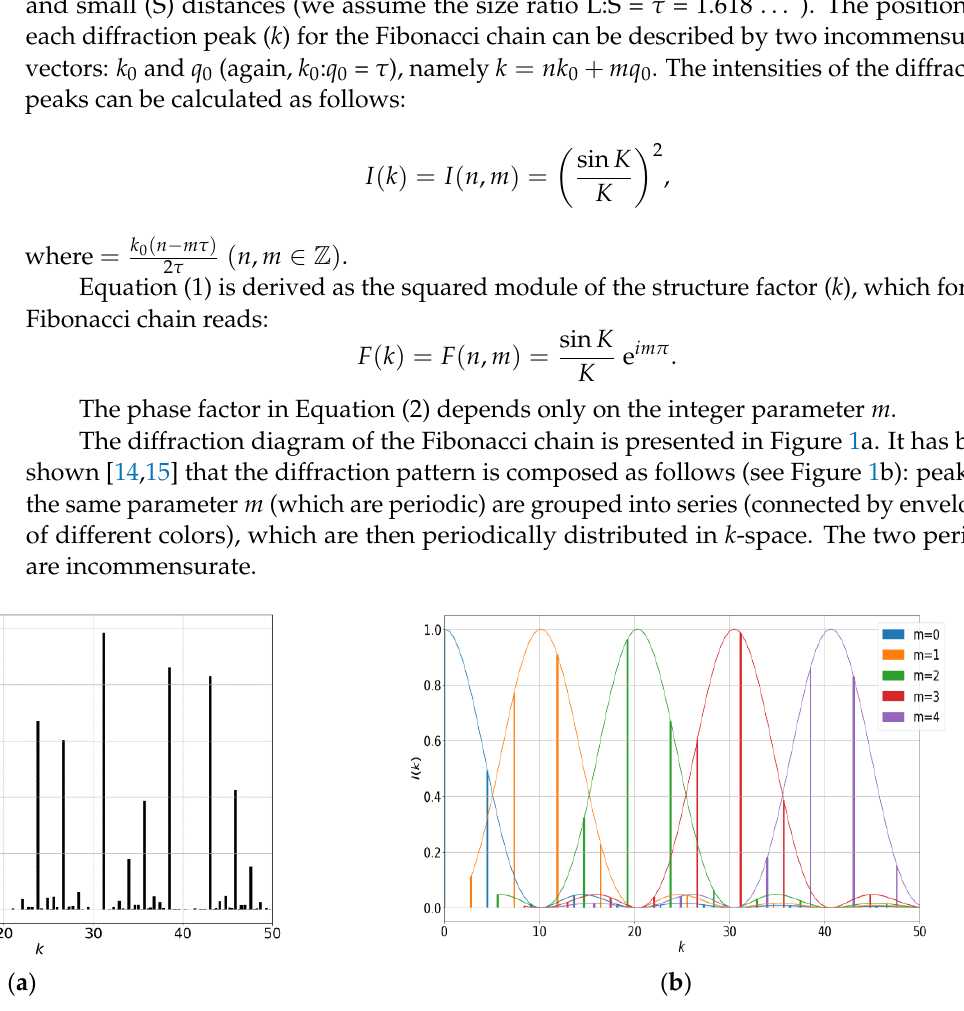
Figure 1. ( a ) Diffraction pattern of the Fibonacci chain ( 𝑘 (cid:2868) = 2𝜋𝜏/(𝜏 (cid:2870) + 1) = 2.81… , indexes 𝑛, 𝑚 ∈ (0,10) , distances L = 𝜏 , S = 1 .). ( b ) Diffraction pattern of the Fibonacci chain with the first five en- velopes marked by different colors.